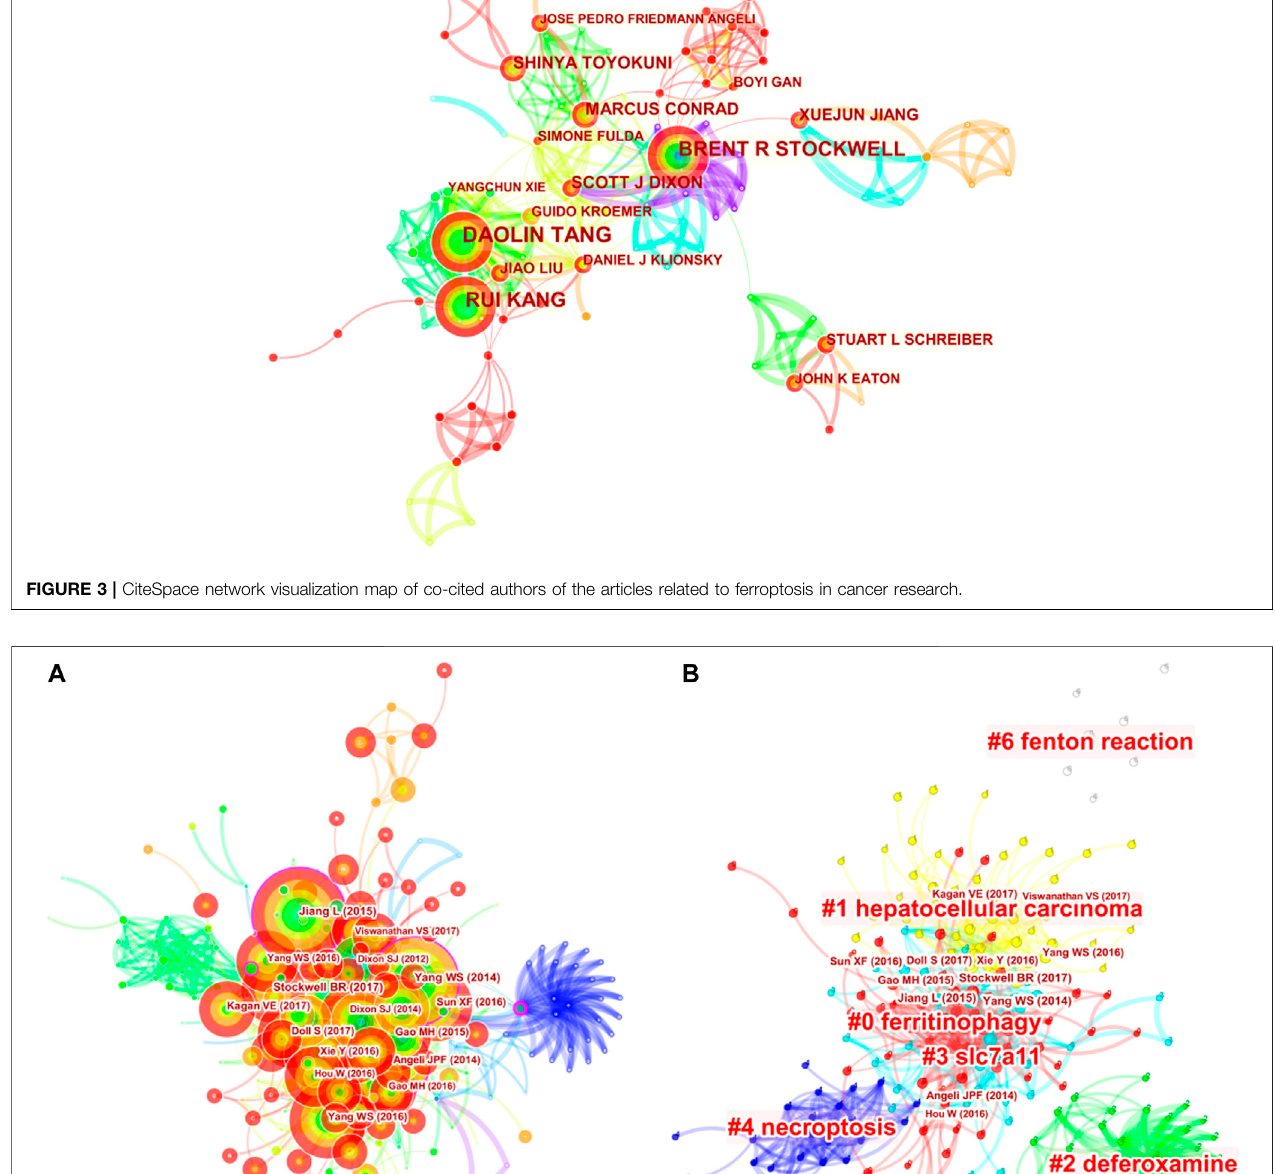
Frontiers in Cell and Developmental Biology |